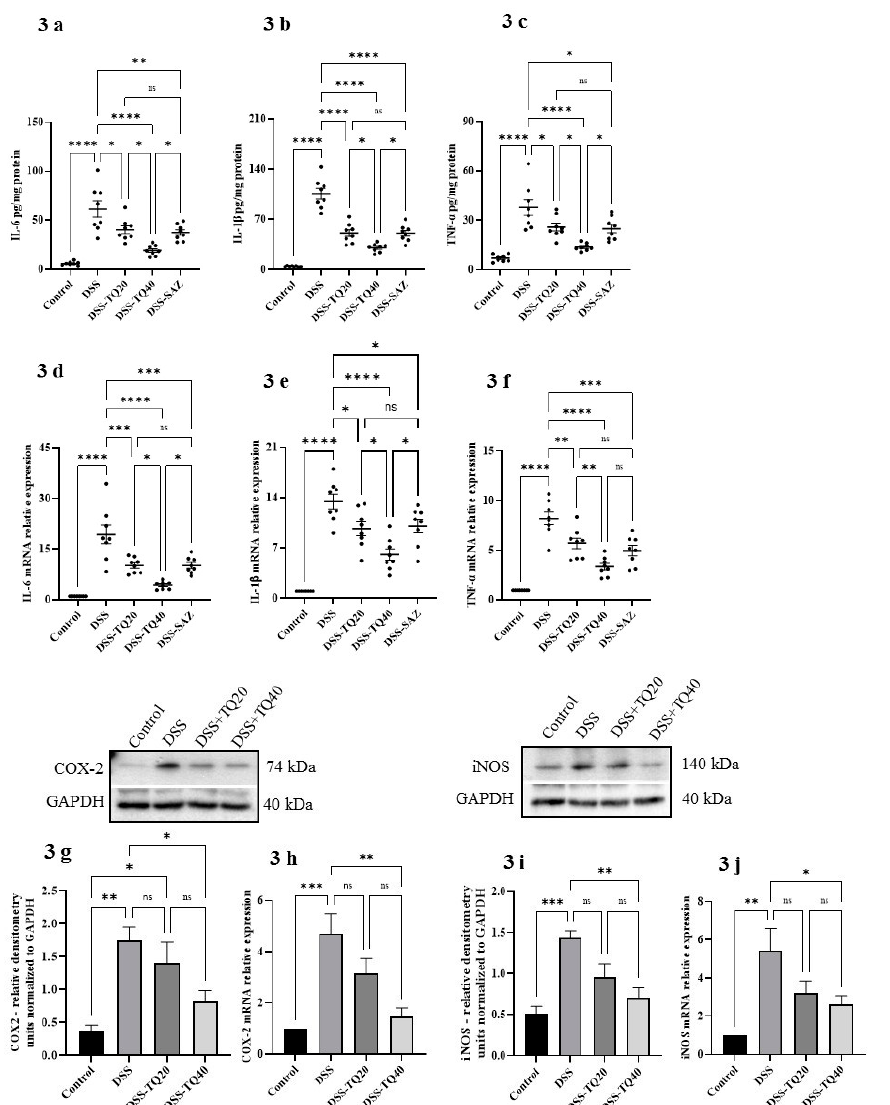
Figure 3. Effects of TQ on proinflammatory cytokines and mediator protein and mRNA expression. TQ treatment significantly prevented the DSS-induced increases in concentrations of proinflammatory cytokines both at protein (IL-6 ( a ), IL-1 β ( b ), and TNF- α ( c )) and mRNA expression levels (IL-6 ( d ), IL-1 β ( e ), and TNF- α ( f )) in DSS-induced colitis group. Similarly, TQ treatment also significantly decreased COX-2 and iNOS levels both at protein and mRNA levels in the DSS-induced colitis group ( g – j ). The density of the immunoblots was normalized to GAPDH as an internal control. n = 8 animals used for obtaining data for proinflammatory cytokines (IL-6, IL-1 β , and TNF- α protein and mRNA) and n = 4 animals used in each group for proinflammatory mediators (COX-2 and iNOS protein and mRNA) expression studies. The data expressed as means ± SEM. **** p < 0.0001, *** p < 0.001 , ** p < 0.01 , and * p < 0.05. (NS) not significant.